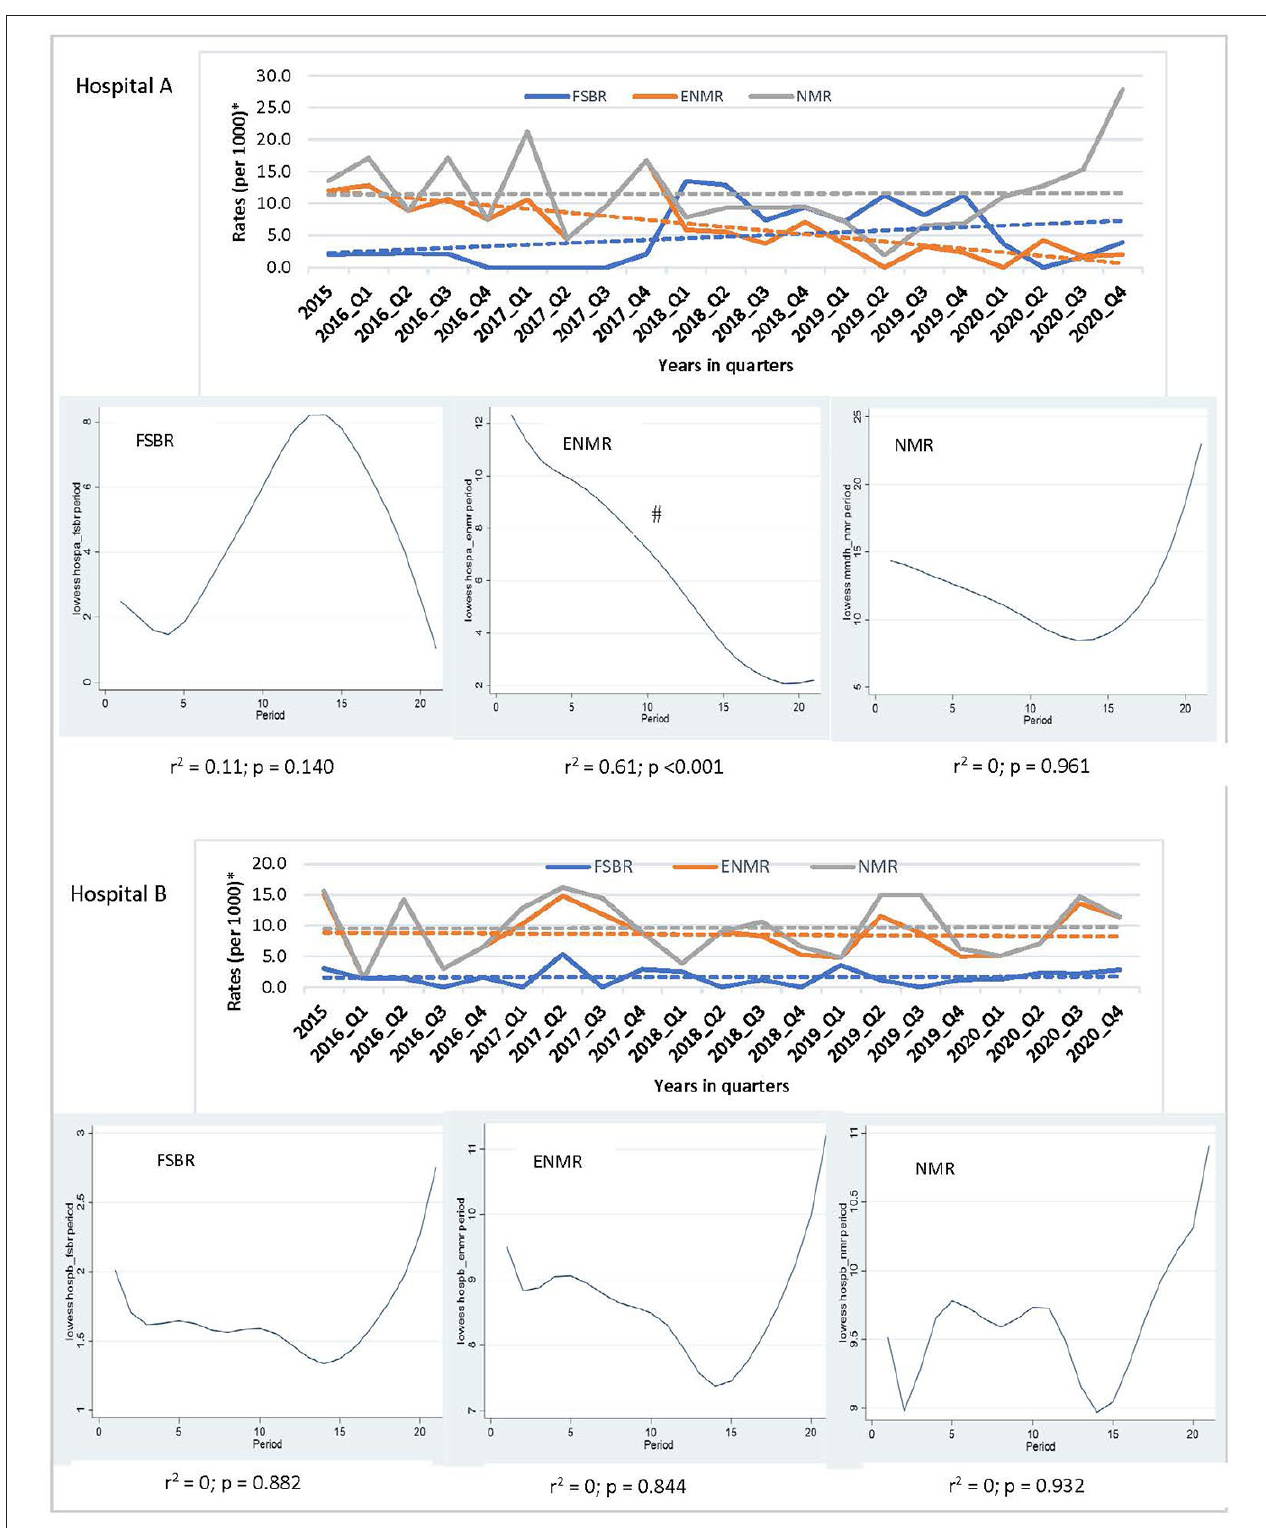
FIGURE 3 | Trends in fresh stillbirth rate (FSBR), early neonatal mortality rate (ENMR), and neonatal mortality rate (NMR), with locally weighted scatterplot smoothing (LOWESS) regression analysis in the lower panel of the Figure for regional hospitals (Hospitals A and B). # Statistically significant reduction ( p < 0.05). * Per 1,000 total births for fresh stillbirth rates (FSBR) and per 1,000 live births for early neonatal mortality rate (ENMR) and neonatal mortality rate (NMR).